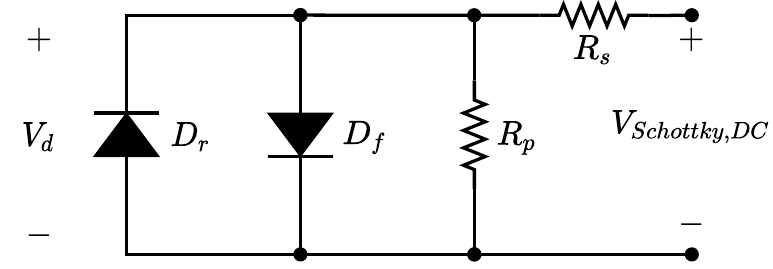
Figure 6. The DC large-signal sub-model.